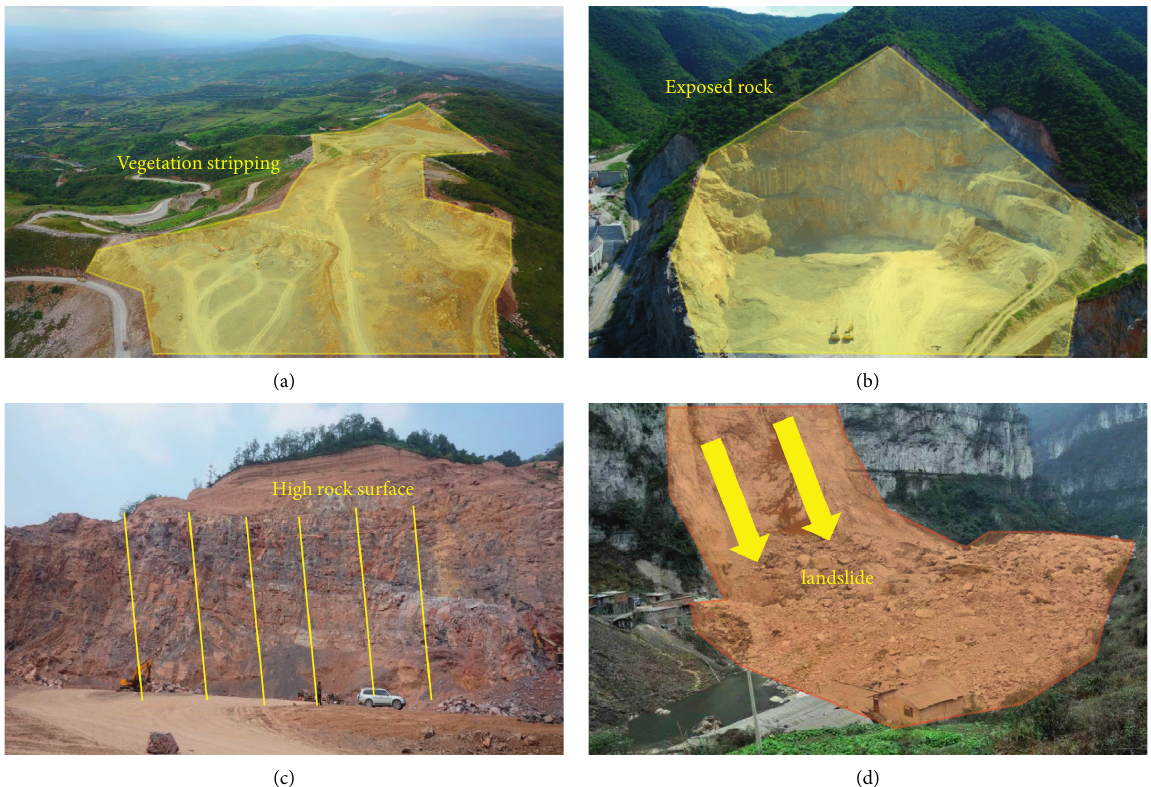
Figure 2: Main geological disasters in Weibei area. (a) Vegetation stripping. (b) Exposed rock. (c) High rock surface. (d) Landslide.